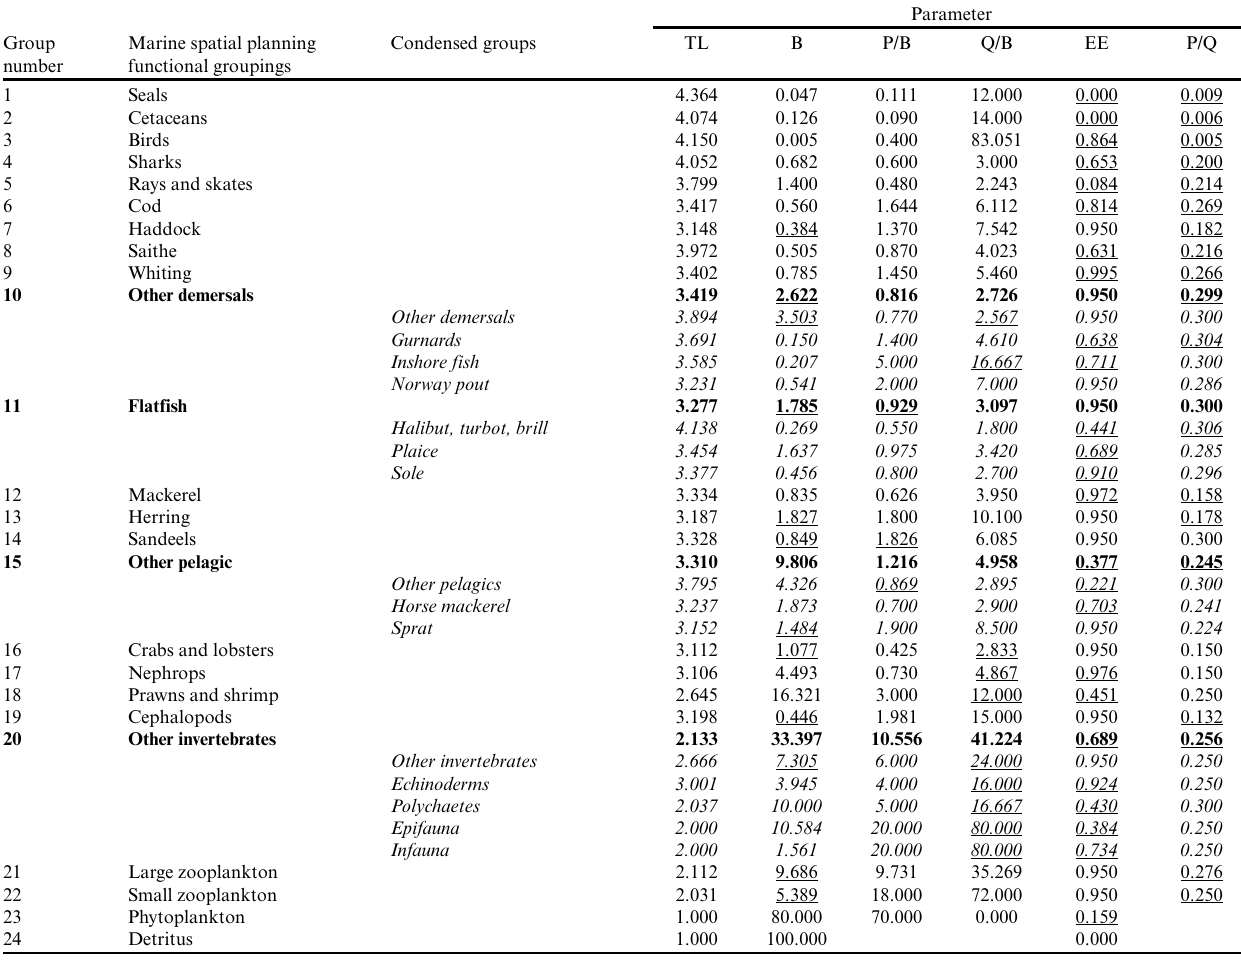
Table 6. Basic estimates for the condensed and balanced marine spatial planning challenge Clyde Sea Ecopath model. Parameters definitions: TL = trophic level, B = biomass (tonne/km²), P/B = production/biomass (per yr), Q/B = consumption/biomass (per yr), EE = ecotrophic efficiency, and P/Q = production/consumption. Parameters estimated by the model are underlined. Functional groups that include more than one of the groups from the uncondensed Clyde Sea model are in bold font and their components are in